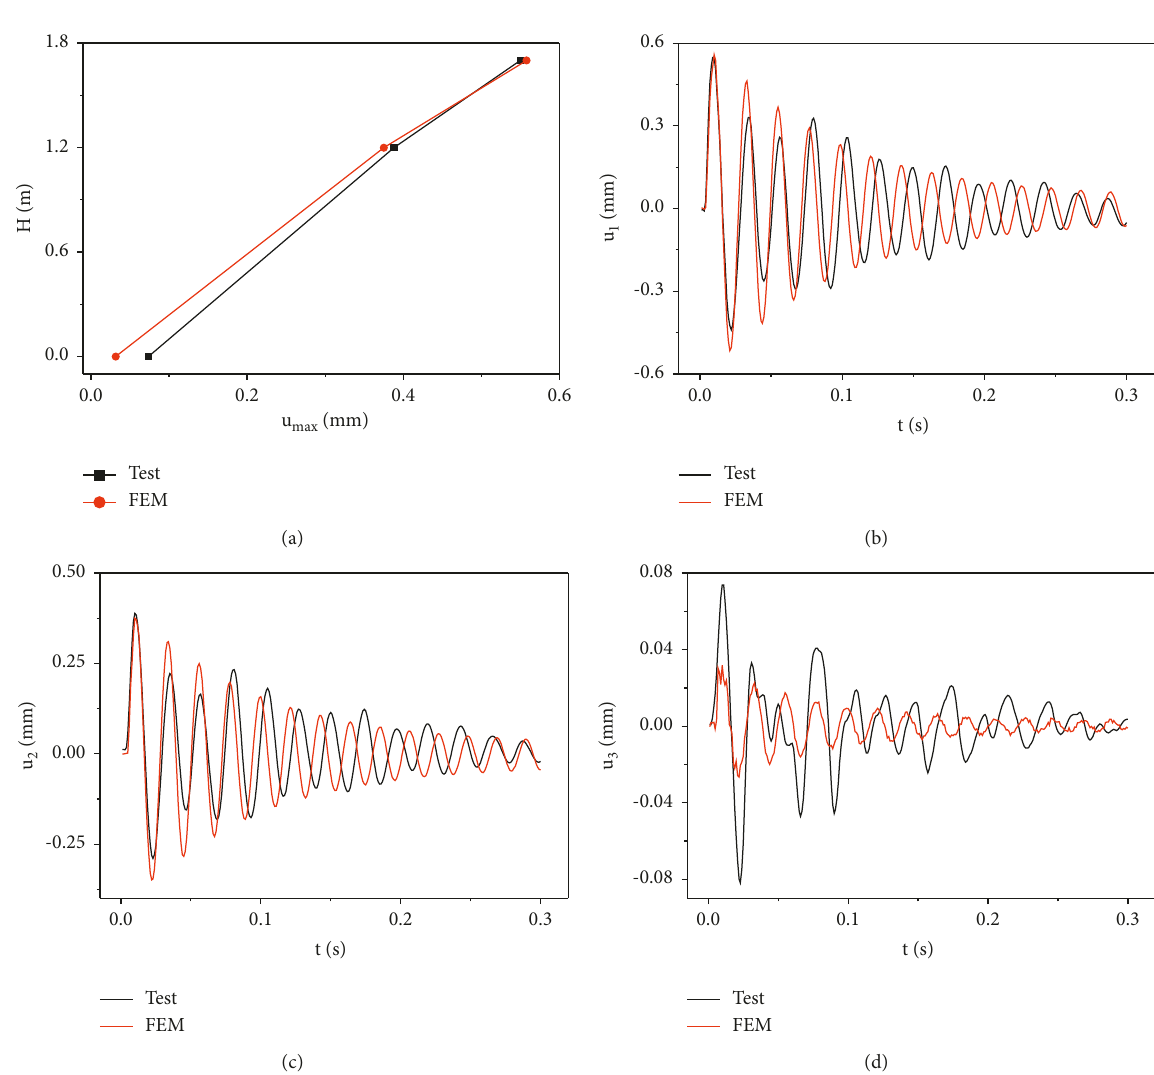
Figure 5: Displacement of pile body under impact of 0.14m pendulum height. (a) Maximum lateral displacement; (b) time history curve of u1; (c) time history curve of u2; (d) time history curve of